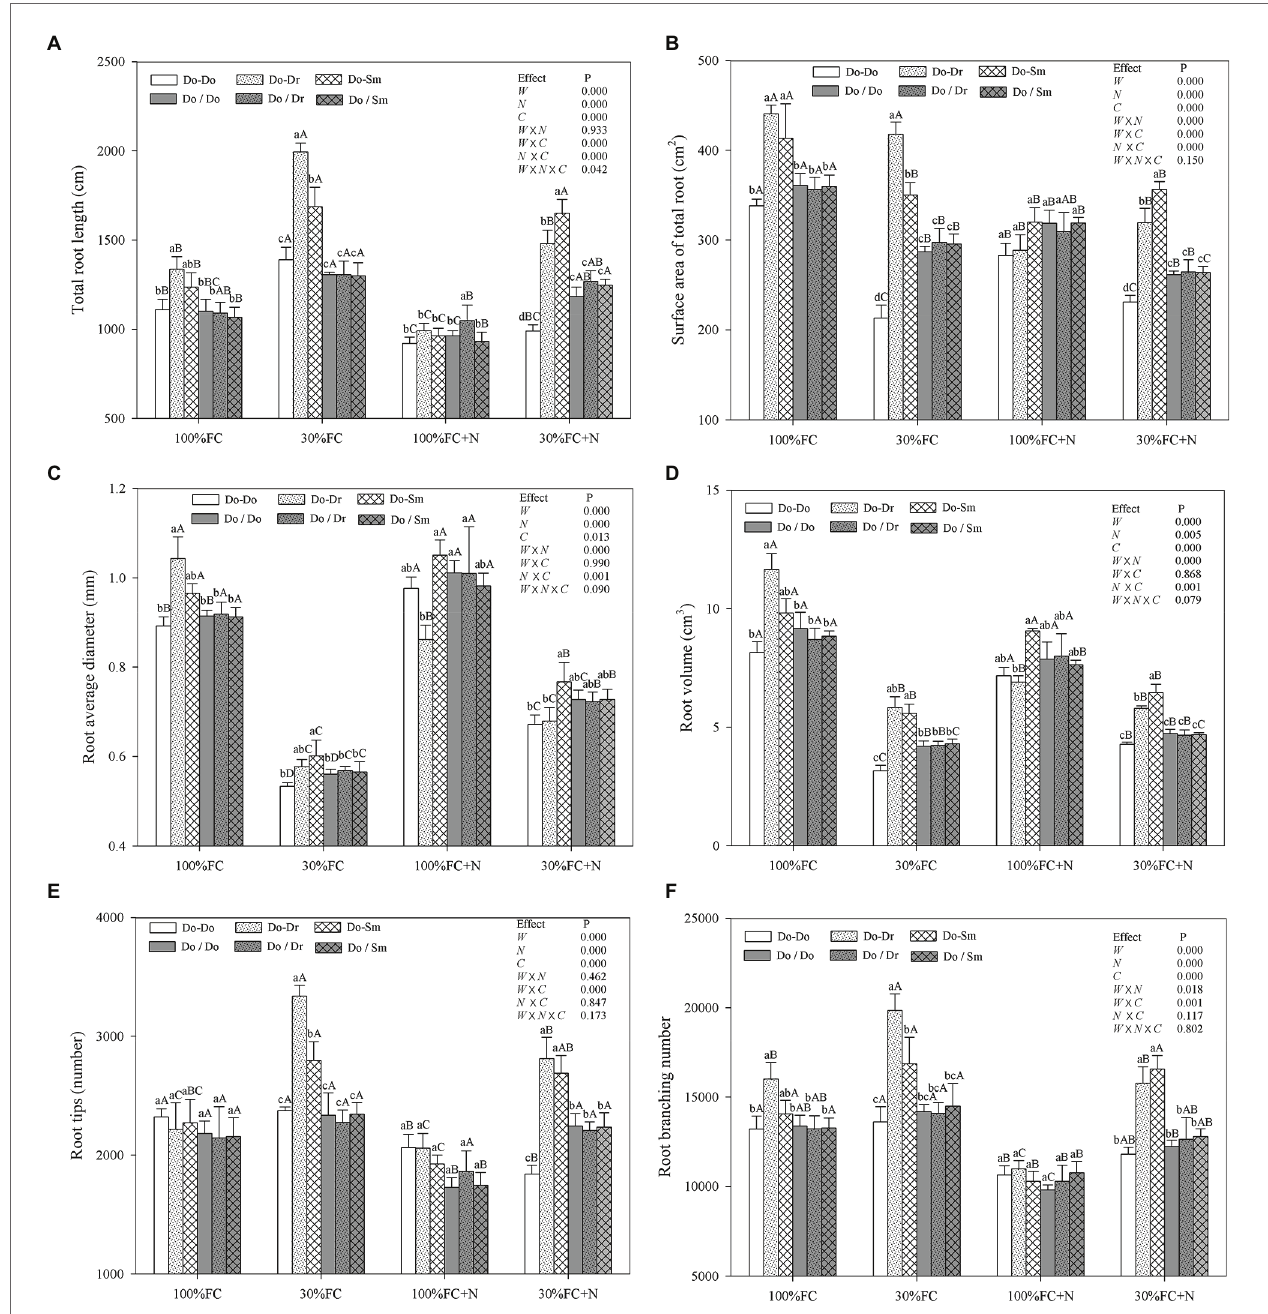
FIGURE 1 | Effects of water, N fertilization levels, and species competition models on total root length (A) , surface area of total root (B) , root diameter (C) , root volume (D) , root tips (E) , and root branching number (F) of D. odorifera . Means ± SEs, n = 5. Different lowercases in each graph indicate significant difference among different competitive models (competition between D. odorifera and various N-fixing niche neighbors) under the same water and N application according to Duncan’s tests ( p < 0.05). Different uppercases in each graph indicate significant difference among different water and N fertilization application in the same competitive models according to Duncan’s tests. 100% FC, 100% field capacity; 30% FC, 30% field capacity; 100% FC+N, 100% field capacity and N fertilization treatment; 30% FC+N, 30% field capacity and N fertilization. Do-Do, Do-Dr, and Do-Sm indicate D. odorifera planted with D. odorifera , D. regia, and S. mahagoni in the root system contact models, respectively; Do/Do, Do/Dr, and Do/Sm indicate D. odorifera planted with D. odorifera , D. regia and S. mahagoni in the root system isolation models, respectively. W, water factor effect; N, nitrogen factor effect; C, species competition models factor effect; W × N, interaction effect of water and nitrogen factors; W × C, interaction effect of water and species competition models factors; N × C, interaction effect of nitrogen and species competition models factors; W × N × C, interaction effect of water, nitrogen, and species competition models factors. Multivariate analysis of variance (Multi-ANOVA) was conducted to evaluate the influence of different factors and their interaction